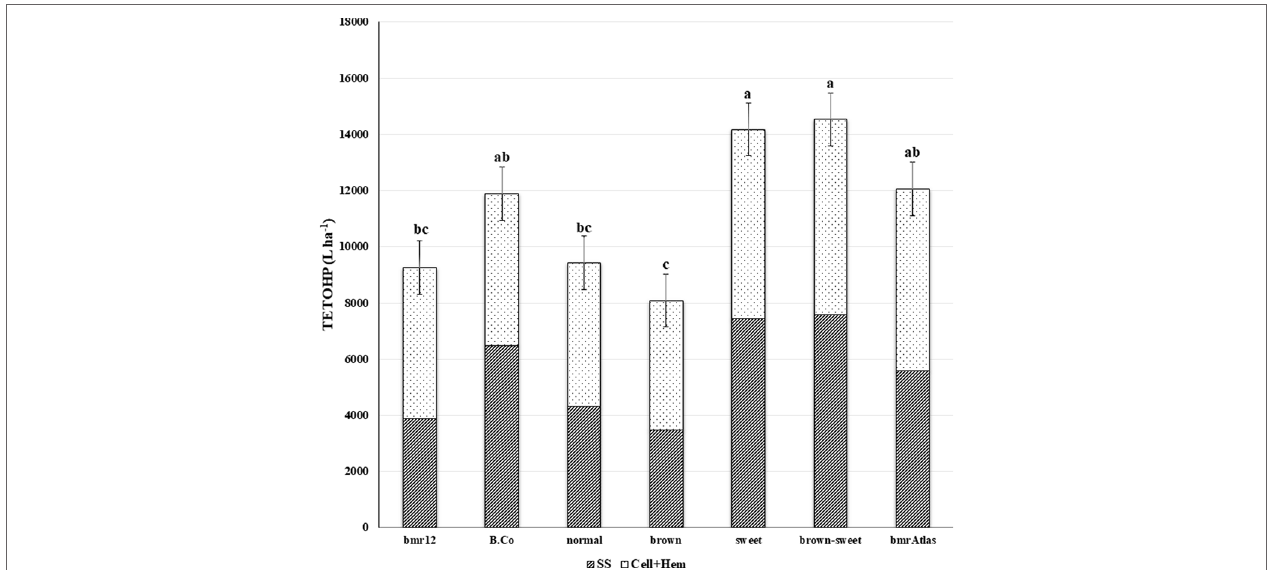
FIGURE 3 | Mean theoretical ethanol production (TETOHP) from two sources of sorghum stover carbohydrates. Striped bars represent TETOHP from soluble sugars (SS) and the dotted bars represent TETOHP from cellulose and hemicellulose (Cell+Hem) estimates of bmr parent ( bmr 12), sweet stem parent (Brown County), four RIL groups (“brown-sweet,” “brown,” “sweet,” and “normal”) and a commercial control ( bmr Atlas). Bars with different letters are significantly different from each other ( P < 0.05). Error bars represent ± one standard error of the mean.